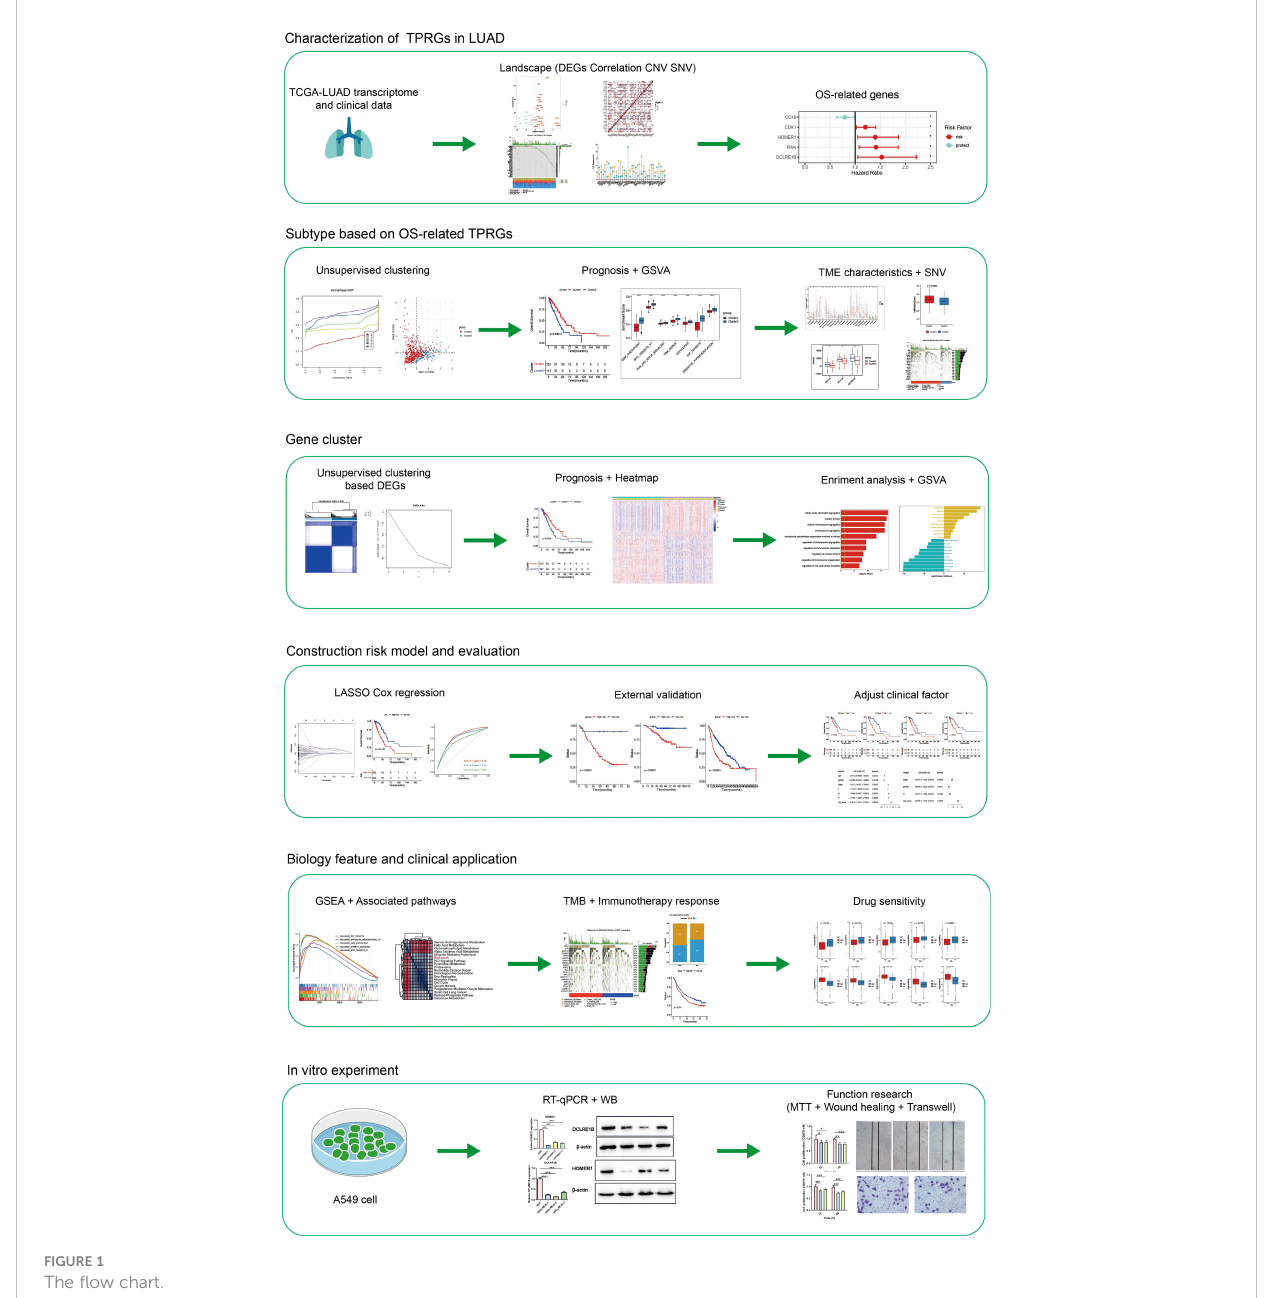
FIGURE 1 The fl ow